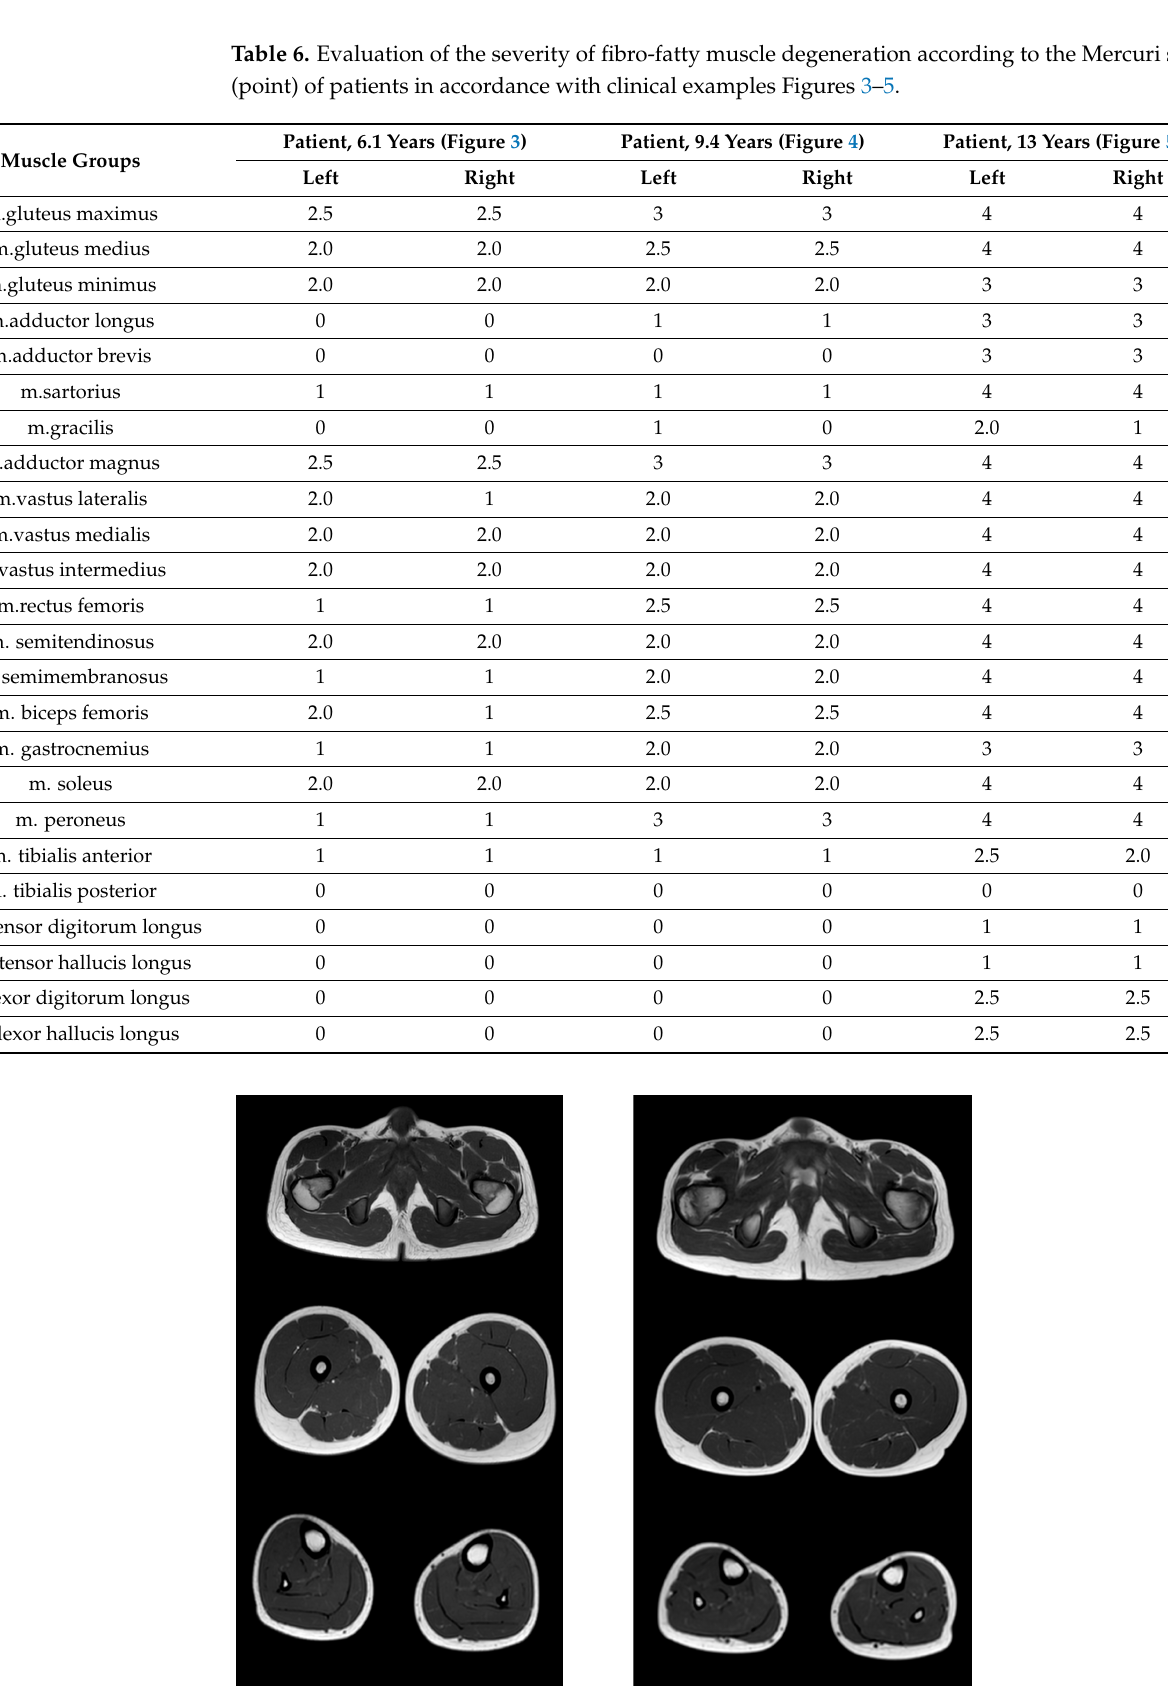
Figure 6. MR images of healthy volunteers 13 years old ( left ) and 8.3 years old ( right ). From top to bottom: the pelvic level, the femoral level and the level of the legs. Table 6. Evaluation of the severity of fibro-fatty muscle degeneration according to the Mercuri scale (point) of patients in accordance with clinical examples Figures 3–5.